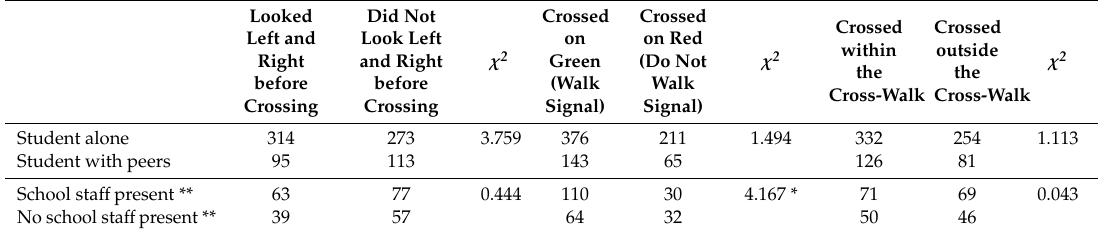
Table 4. E ff ects of other people on road-crossing behaviours (number of road